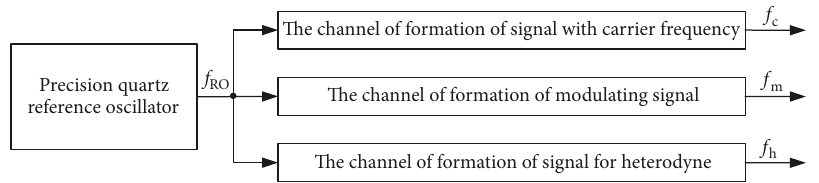
Figure 1: A generalized block diagram of a multichannel system the formation of signals of georadars with a synthesized aperture.